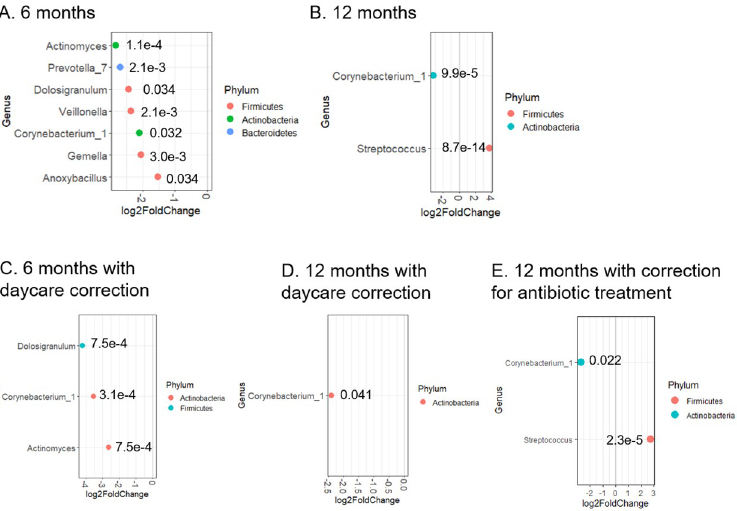
Fig 3. Bacterial genera that show differential abundance between Spn+ and Spn- samples. Abundance of bacterial genera was compared between Spn+ and Spn- samples collected at 6 months (A), or at 12 months (B) without correction for daycare attendance, or with correction for daycare attendance (C, 6 months; D, 12 months) using DESeq2 software (see Materials and methods). The ones with adjusted p value less than 0.05 are shown as dots in the graphs. The adjusted p value is indicated next to each dot. The x axis exhibits the log 2 ratio between abundance of bacterial genera in Spn+ samples and that in Spn- samples.